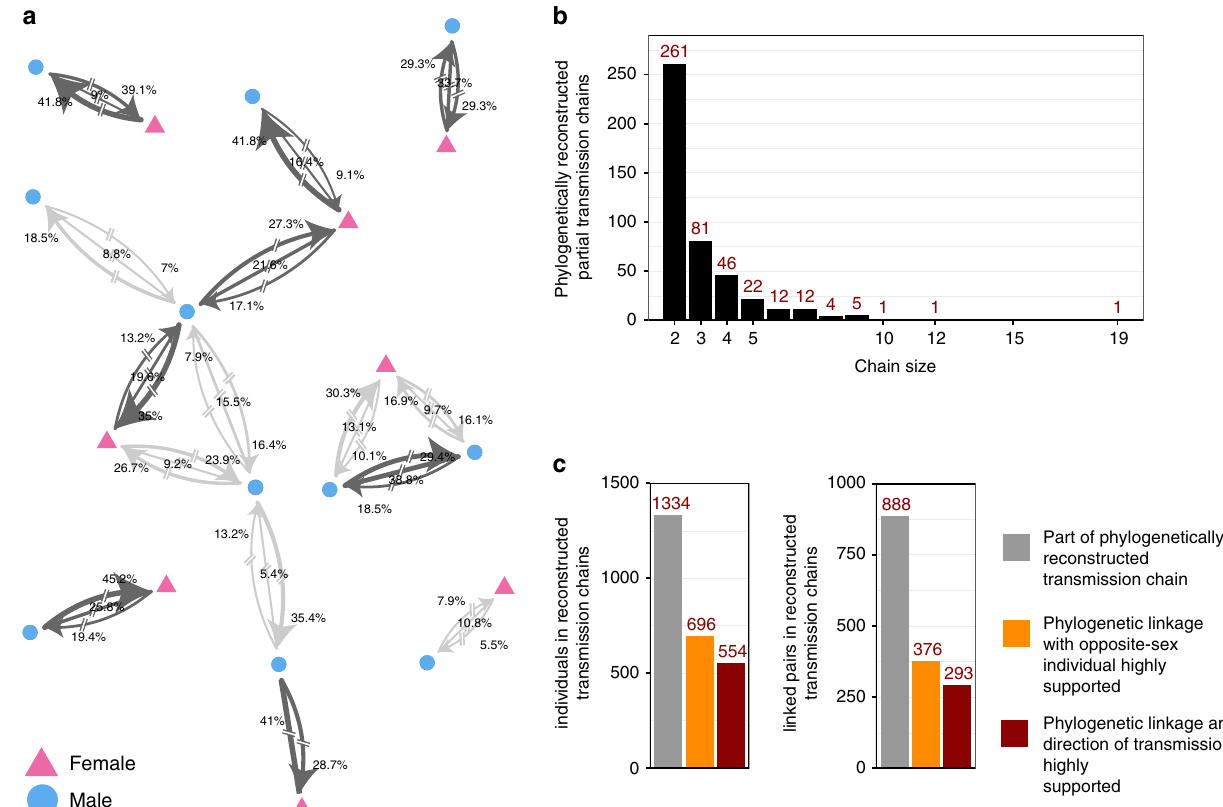
Fig. 5 Phylogenetically reconstructed transmission networks. Four hundred and forty-six transmission networks comprising 1334 individuals and 888 linkages could be reconstructed from the population-based sample. a Illustrative set of six transmission networks with nodes indicating gender. In comparison to phylogenetic clustering analyses, deep-sequence phylogenetic analysis provided evidence about the direction of transmission. Edges connecting two individuals were labelled with the statistical support for transmission in the indicated direction (for directed edges), or for transmission with no evidence for direction (for undirected edges), calculated as the proportion of deep-sequence phylogenies supporting each case (see Fig. 4). The sum of the three weights quanti fi ed the phylogenetic support for direct transmission on a scale between 0 and 1 ( ^ λ , see Fig. 4). Pairs of individuals with high ij support for direct transmission were highlighted in dark grey ( ^ λ ij > 0 : 6). All edges were broken to indicate the possibility of unsampled intermediates. b Sizes of reconstructed transmission chains. The majority of transmission chains (261/446, 58.5%) were pairs, though 36 chains had more than fi ve individuals. c Numbers of individuals (left) and linked pairs (right) in reconstructed transmission chains. Many linked pairs were weakly supported or between individuals of the same sex, which indicated the presence of unobserved intermediates or common sources. In all, 376 male − female pairs had high support ð ^ λ ij > 0 : 6 Þ (orange bars), and of those, the direction of transmission could be inferred with high support ð ^ δ ij > 0 : 6 Þ in 293/376 (77.9%)